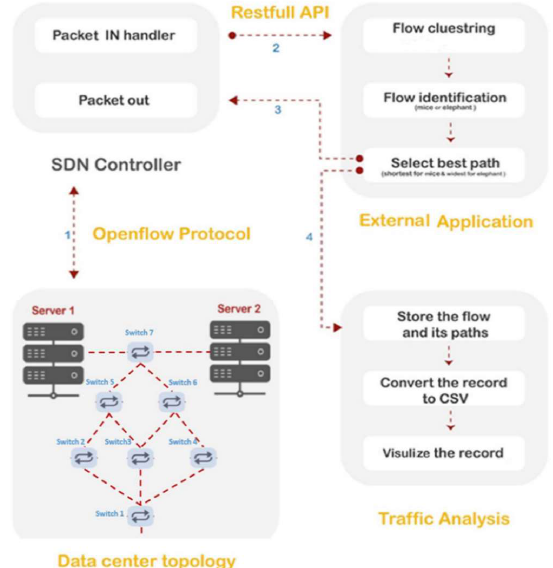
Figure 2. SDN-Based Application Framework.